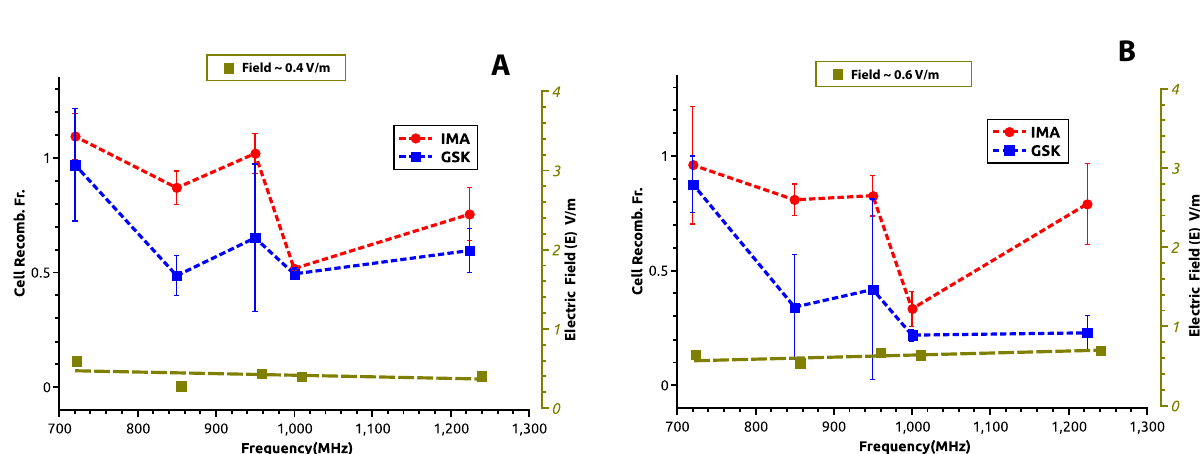
Figure 5. Variation of cell recombination fraction (+ EMF/-EMF) with the field irradiation frequency shown in each panel for a constant receiver EMF electric intensity field E calculated in the cell culture medium. ( A ) EMF electric field intensity E 0.4 V/m, ( B ) EMF electric field intensity E 0.6 V/m. The pharmacological agents stimulating RAG expression GSK-690693, GSK-blue, and Imatinib, IMA-red. The pale green dotted line shows the relative constant distribution of measured electric field as a function of frequency. The error bars represent standard deviation (SD) values from three independent